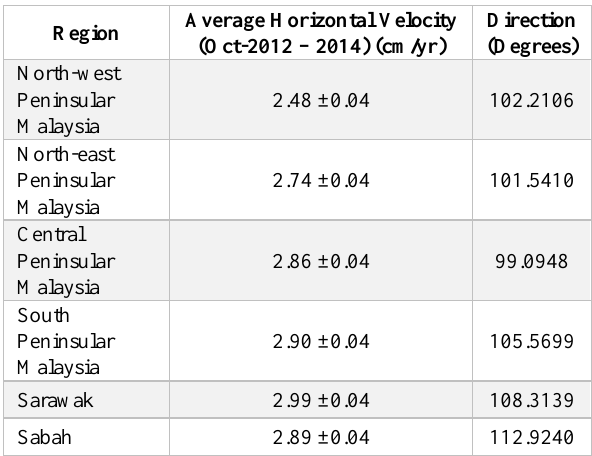
Table 3. Averaged horizontal velocities of Malaysia by region and their directions for the Oct-2012-2014